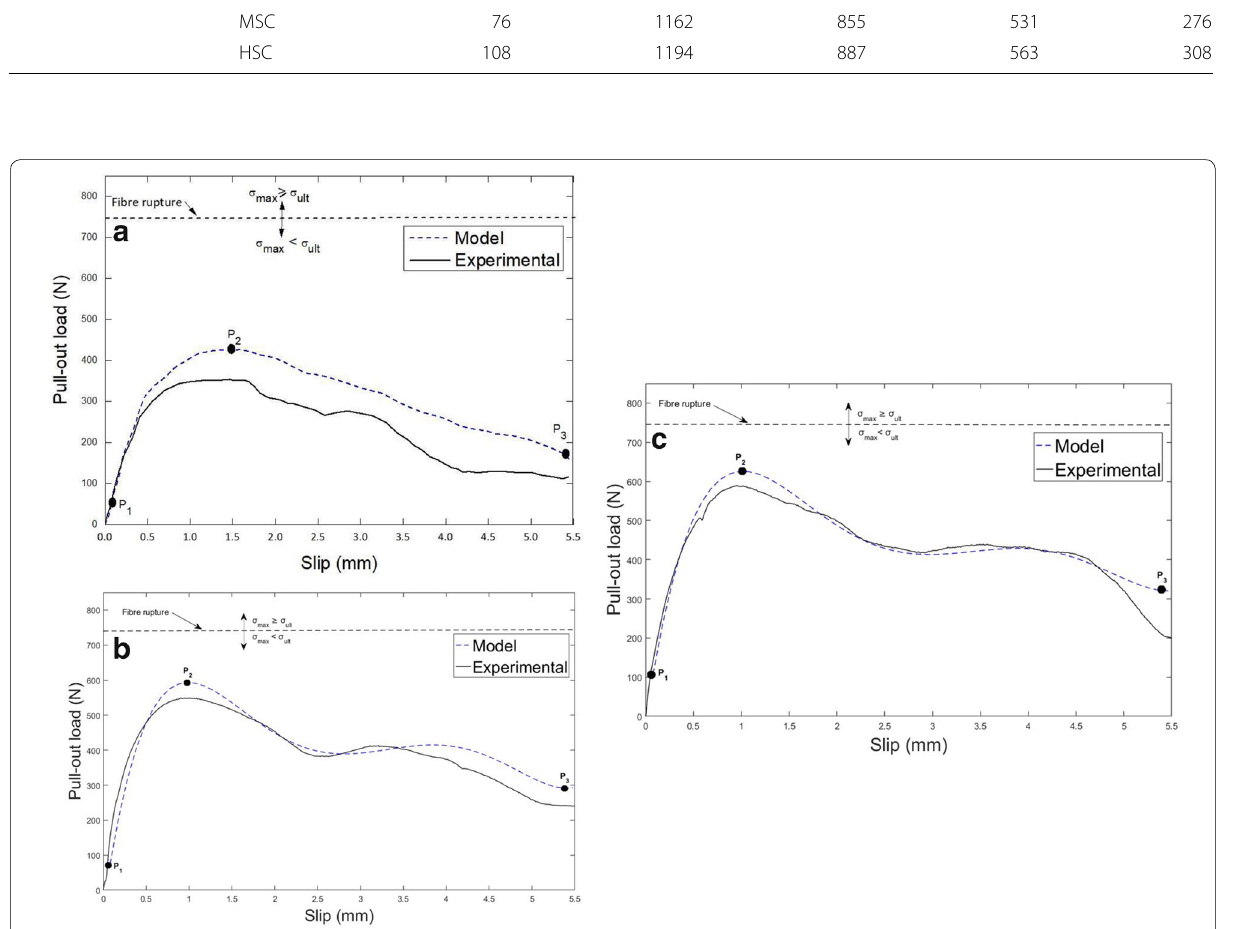
Fig. 17 Comparison of the predicted and experimentally measured pull-out curves for 3DH fibre. a NSC, b MSC and c HSC